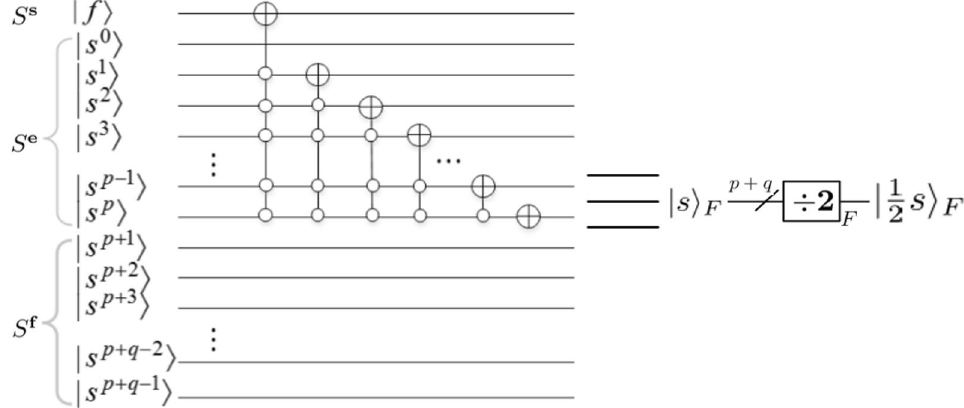
Figure 11. Divided by 2 module 12 .